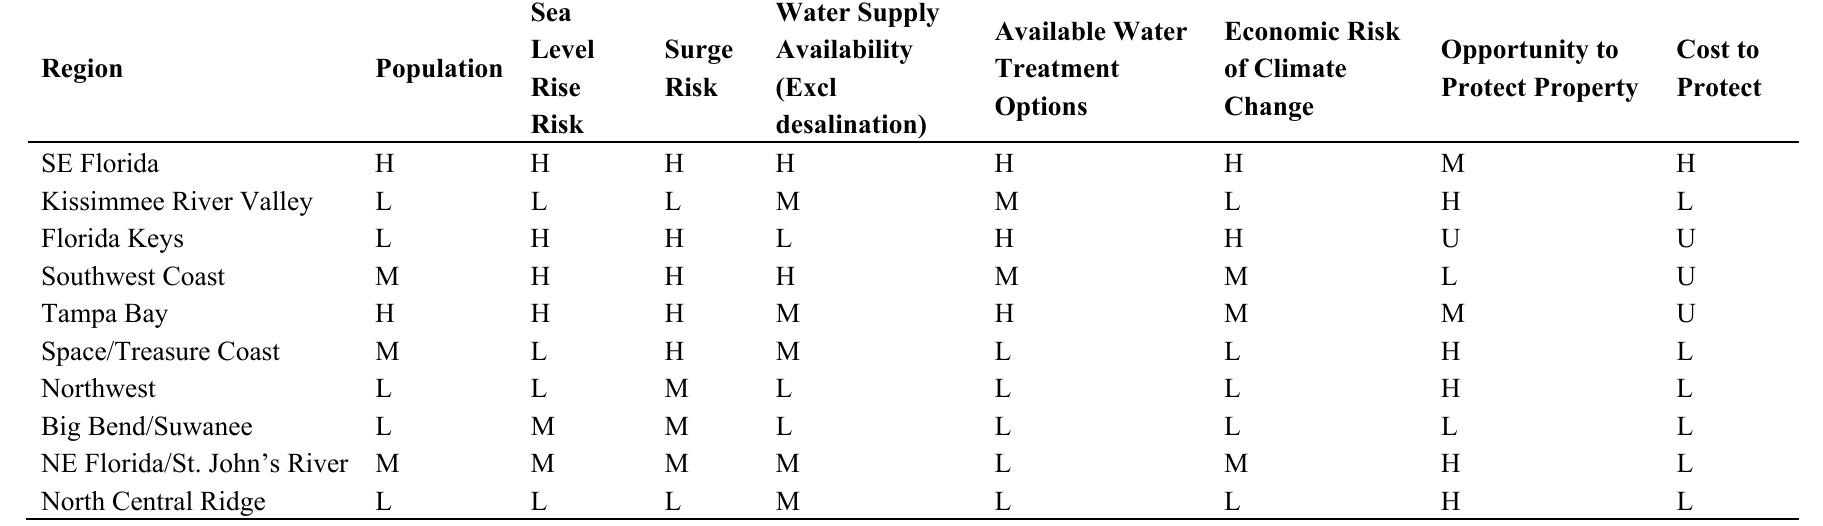
H= high; M = medium; L =